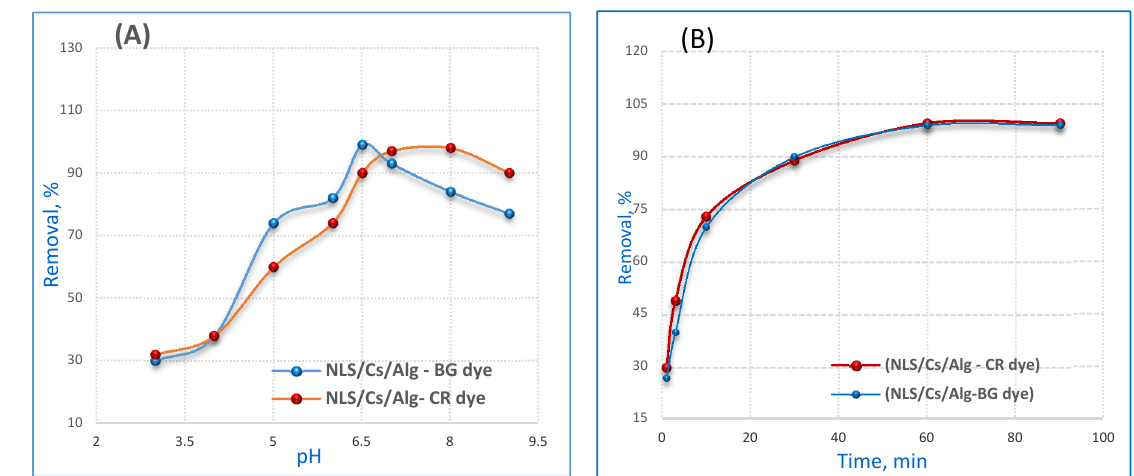
Figure 4. Influence of ( A ) pH and ( B ) time on the adsorption of 12 mg/L CR or BG dye by 0.02 g/100 mL NLS/Cs/Alg. nanocomposite.